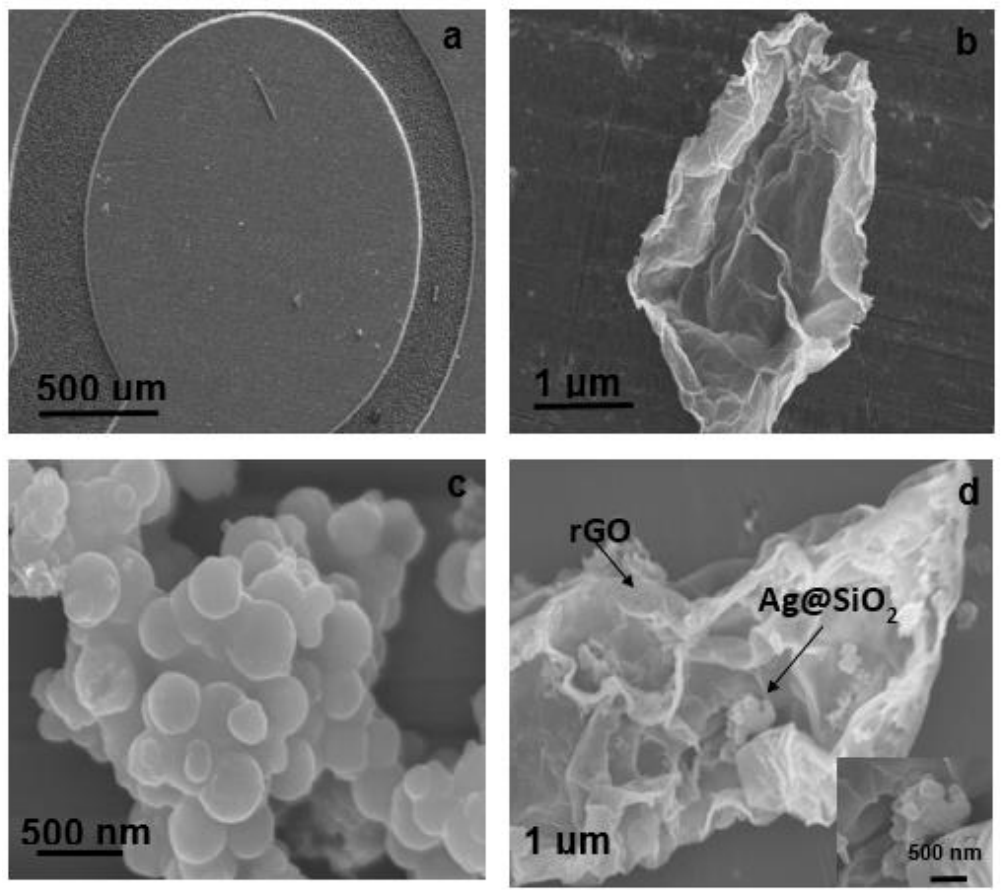
Figure 1. Scanning electron microscopy ( SEM) images of ( a ) bare Au PCB, ( b ) rGO/Au PCB, ( c ) Ag@SiO 2 /Au PCB, and ( d ) rGO- Ag@SiO 2 /Au